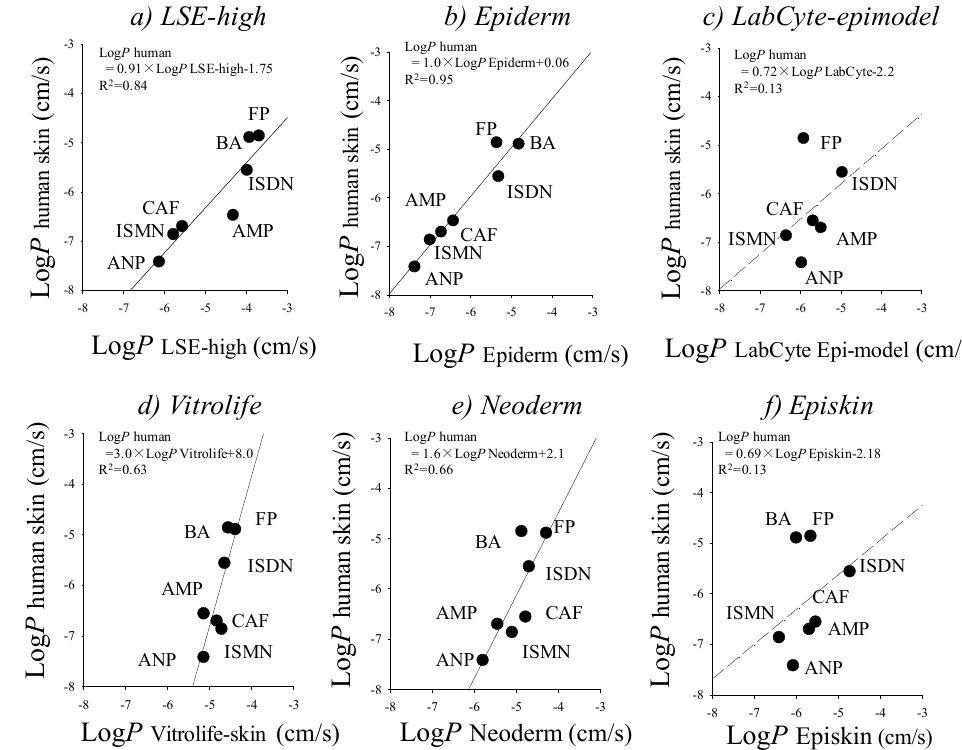
Figure 2. Relationships between log p -values of excised human cadaver skin and log p -values in cultured skin models. ( a ) LSE-high versus excised human cadaver skin; ( b ) EpiDerm versus excised human cadaver skin; ( c ) Vitrolife-skin versus excised human cadaver skin; ( d ) Neoderm-E versus excised human cadaver skin; ( e ) LabCyte EPI-model versus excised human cadaver skin; and ( f ) Episkin versus excised human cadaver skin. Each point represents the mean ± S.E. ( n = 4–6). Cited from [34].